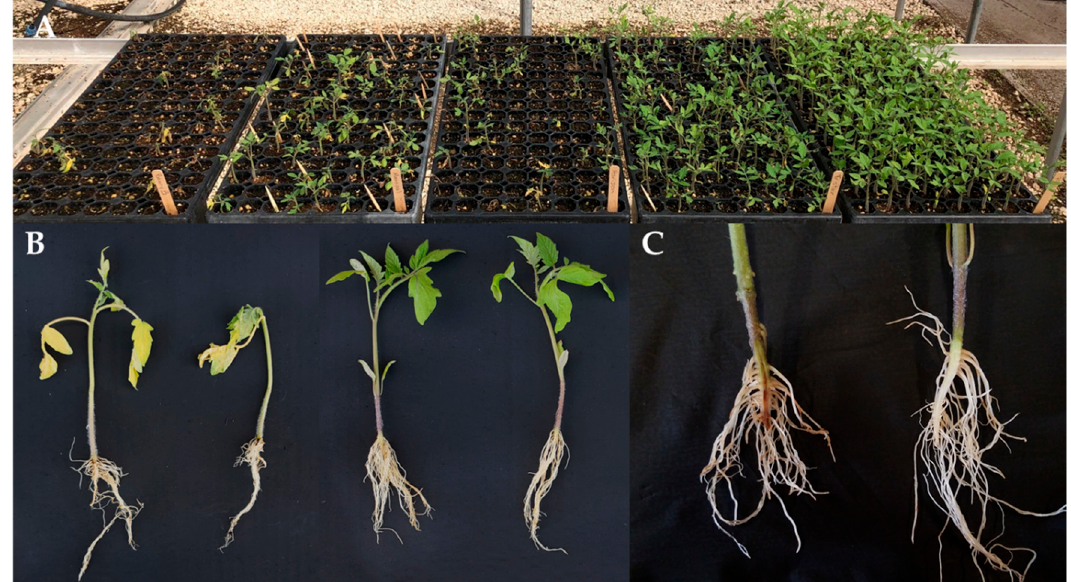
Figure 2. Symptoms observed in Fol3 seedling disease assays. ( A ) From left to right, trays contain ‘Bonny Best’ (susceptible to all three races), ‘Manapal’ (contains I ), ‘Horizon’ (contains I and I-2 ), ‘Tristar’ (contains I , I-2 , and I-7 ), and Fla. 7946 (contains I , I-2 , and I-3 ). ( B ) Two susceptible plants on the left are compared with two resistant plants on the right. ( C ) Root dissection reveals the vascular browning in a susceptible plant (left) compared with a resistant plant (right).